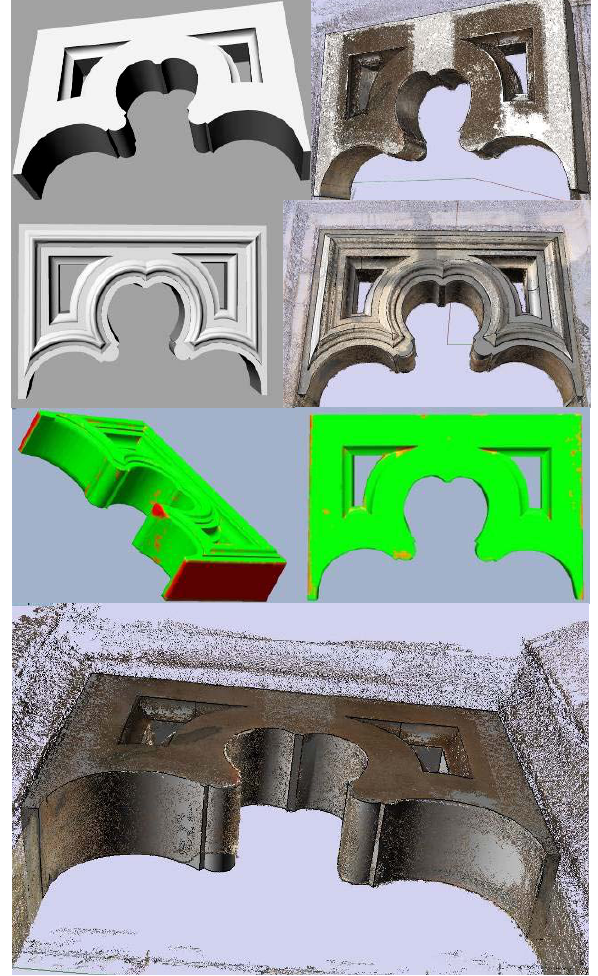
Figure 10: The 1:1 model of a statically important object to be rebuilt automatically. The model is done in rhino from the point cloud extracted from images. The deviation between reconstructed model and original point cloud is checked using RapidformXO. Green corresponds to the areas where the maximal deviation is 2mm. In the red area, the object shows some damage that is eliminated in the modelling phase. It was restored